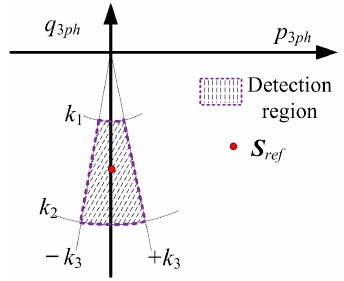
Figure 1. Islanding detection region.